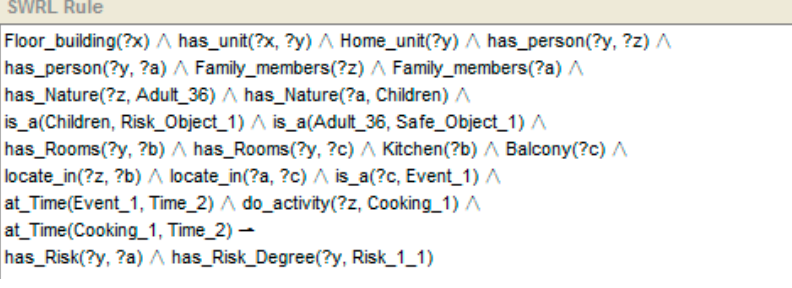
Figure 11. An example of risk recognition reasoning based on rule (child on balcony along).